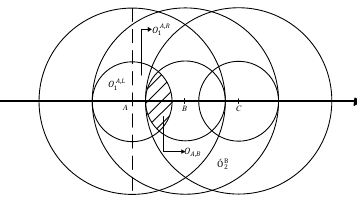
Figure A1. The illustration of proof of the second